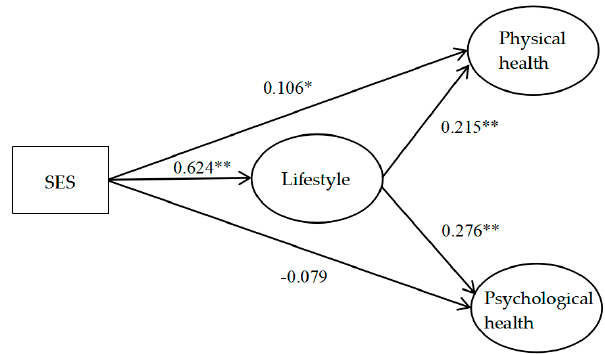
Figure 2. Structural equation model with standardized estimates. Notes: * Significant at level p < 0.05, ** Significant at level p < 0.01.